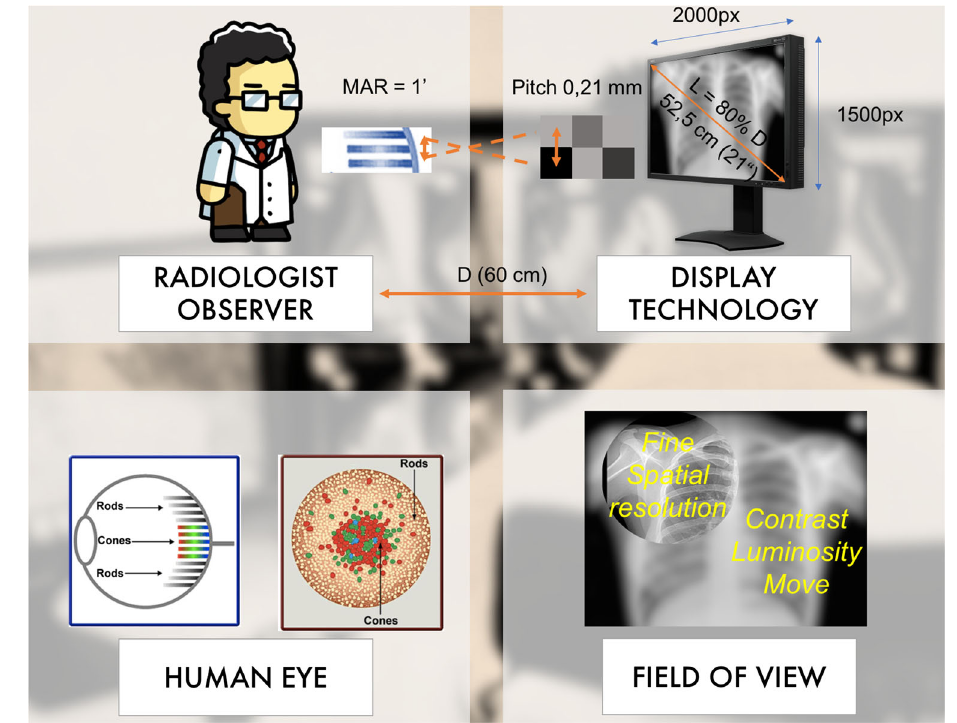
Fig. 2 The human – machine interaction is constrained by human and contextual factors. Typically, the display is around 60cm fromthe radiologist. Atthis distance, the field of view is around 50 cm (around 21 in.). Considering the maximum angular resolution of the eye, the display can have maximum pitch of 0.21 mm. This corresponds to a 3-megapixel screen. The human retina contains two types of photoreceptors, rods and cones. The cones are densely packed in a central yellow spot called the B macula ^ and provide maximum visual acuity. Visual examination of small detail involves focusing light from that detail onto the macula. Peripheral vision and rods are responsible for night vision and motion